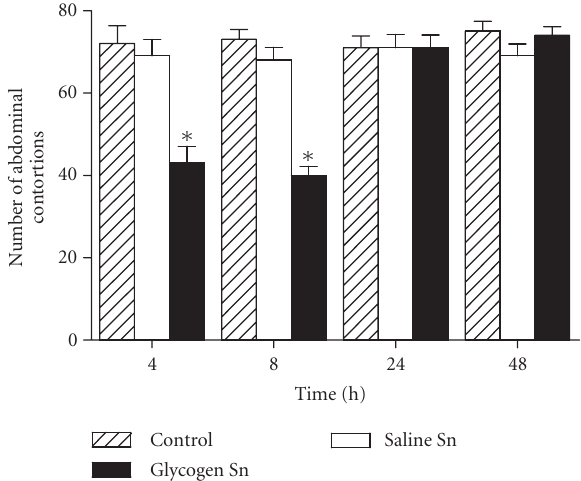
Figure 3: E ff ect of cell-free exudates obtained 4, 8, 24 or 48hours after glycogen injection (Glycogen Sn) in naive animals submitted to the writhing test. The exudate supernatants (200 μ L/cavity) were injected 30minutes before the test. Animals injected with super- natants obtained after saline injection (Saline Sn) were also evalu- ated. Controls were injected only with acetic acid. Values represent SEM of 8–16 animals for each group. (cid:0) P < . 05 in com- the mean (cid:0) parison with values obtained in control animals.